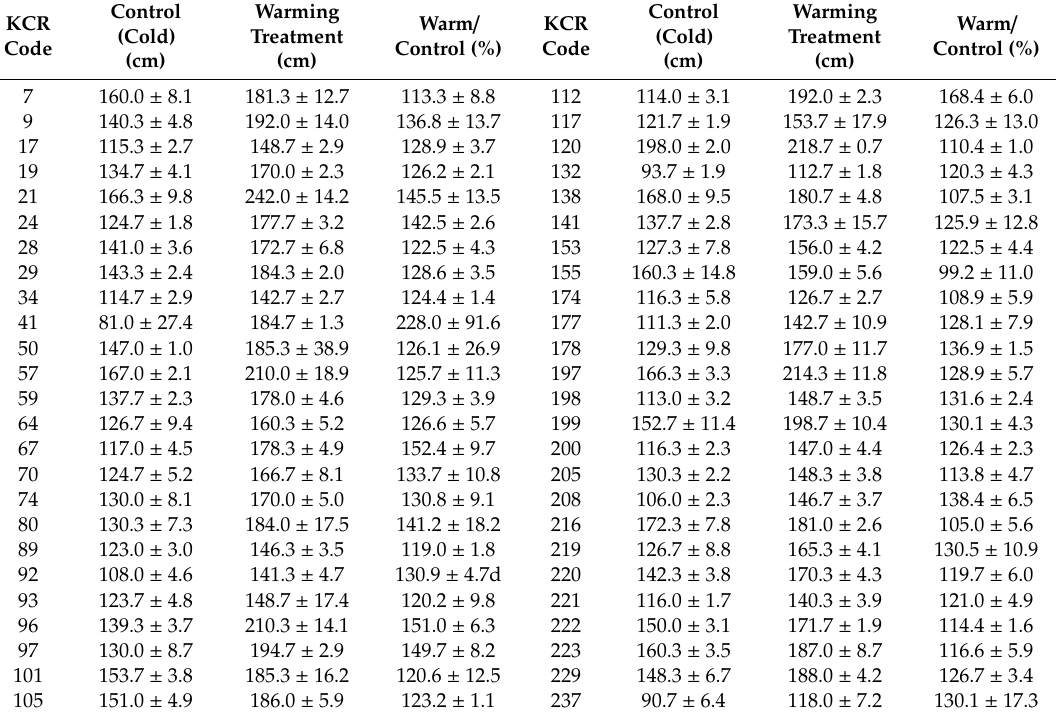
Table 5. Shoot length of varieties under the control (cold) condition and warming